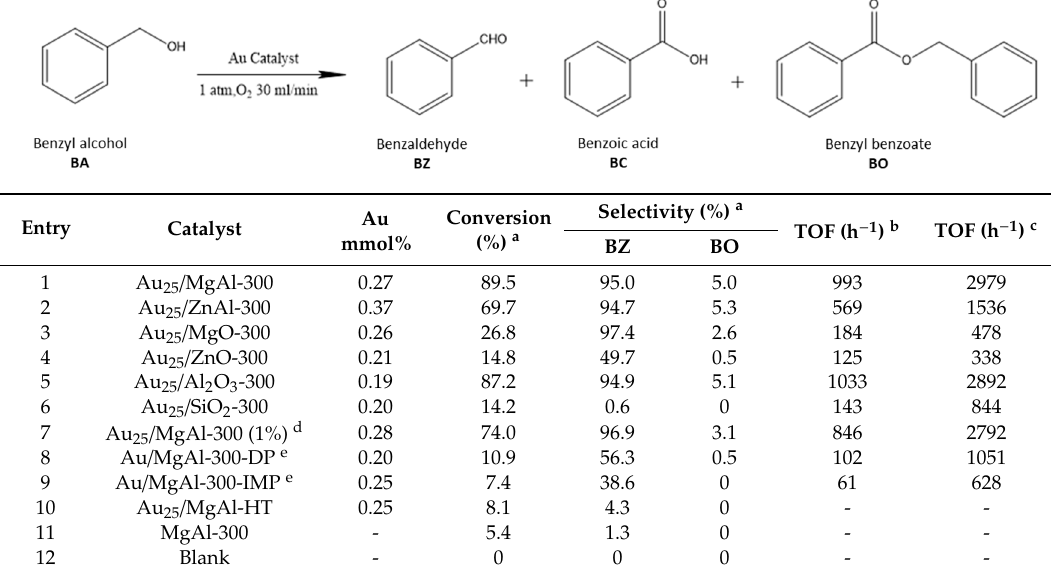
Table 2. Catalytic performances of supported Au catalysts in benzyl alcohol oxidation.